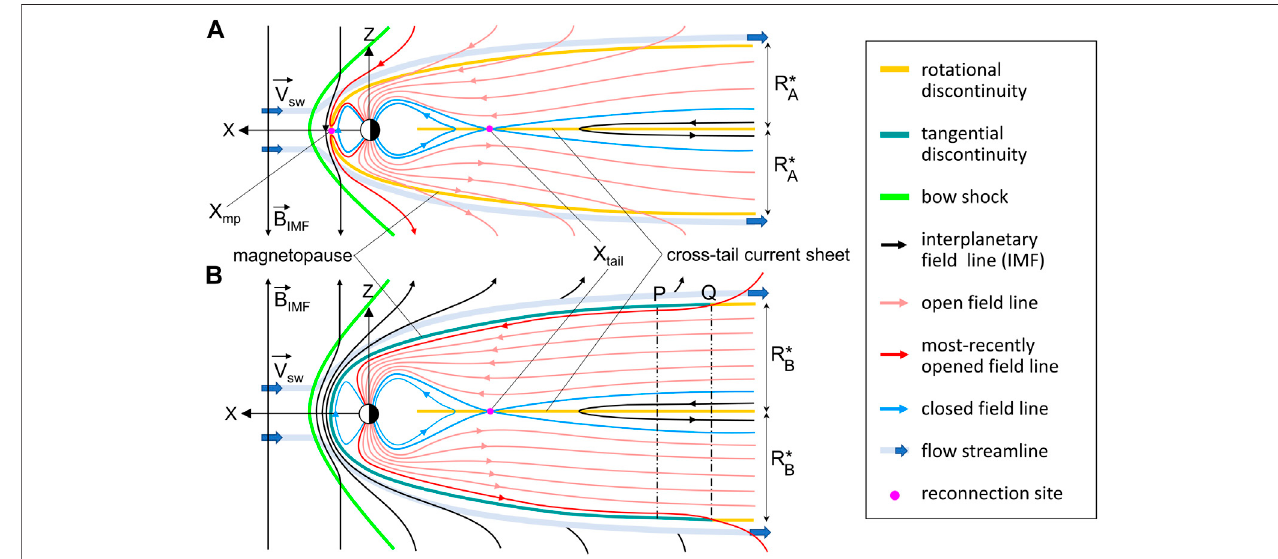
FIGURE 1 | Noon-midnight meridian cuts of the magnetosphere, viewed from the from the dusk fl ank: the X (sunward) and Z (northward) axes in the Geocentric Solar Magnetospheric frame (GSM, in which the X axis points towards the Sun and the Z axis is the projection of Earth ’ s magnetic axis onto the YZ plane) are shown. Parts (A) and (B) arefortimes t A and t B whentheIMFwassouthwardandnorthwardrespectivelywhere t B > t A ,andtheIMFhasbeennorthwardforalltheinterval t A < t ≤ t B .In A thesouthward-directedinterplanetarymagnetic fi eld(IMF)givesmagneticshearacrossthedaysidemagnetosphere,andthisdrivesmagneticreconnection at X mp between closed geomagnetic fi eld lines (in blue) and (shocked) interplanetary fi eld lines (in black), and thereby generating open fi eld lines that thread the magnetopausecurrentsheet(inred/pink:mostopen fi eldlinesareshowninpinkbutthemostrecentlyopened oneisshownindarkerred).Open fi eldlinesthreadingthe magnetopausecurrentsheetmakeitarotationaldiscontinuity, showninorange.Open- fi eldlinesarere-closedbyreconnectionatX tail inthecross-tailcurrentsheet(also a rotational discontinuity and so also shown in orange). In part (B) , the northward pointing IMF means that reconnection in the subsolar magnetopause has ceased and the because the northward IMF has persisted for along interval ( t B − t A ), the last fi eld line to be opened (in red) has been swept a large distance in the − X direction by the solar wind fl ow (a typical solar wind speed of 400 kms − 1 corresponds to 150 R E per hour (where 1 R E is a mean Earth radius = 6370 km). In comparison, the dayside magnetopause is typically at X of between 10 R E and 15 R E and so, given we here consider intervals ( t B − t A ) of several hours, the X axis in the tail is necessarily greatly compressed in these schematics. In part (B) , most of the magnetopause is now a tangential discontinuity (shown in dark green) and is only threaded by open fl ux at the most negative X values shown. Note that three of the northward-pointing IMF/magnetosheath fi eld lines are shown as remaining in the non-midnight meridian, being draped over thenose of the magnetosphere,buttwo others are moving round the dawn or dusk fl ank, out ofthe plane of the diagram. The appending of open fi eld lines to the tail by the solar wind fl ow between the times t B and t A has fl ared the tail, increasing its asymptotic radius from R * A to R * B . The point where the last fi eld lines to be opened thread the magnetopause have, by the time t B , reached the tail cross-section shown by the vertical black dot-dash line labelled Q (at X = X Q ) and all open fi eld linesareparalleltothesolarwind fl owbythetailcrosssectionlabelledP(at X = X P ).Earthwardofthe X = X P ,thesolarwind fl owisnolongergenerating fi eld-perpendicular